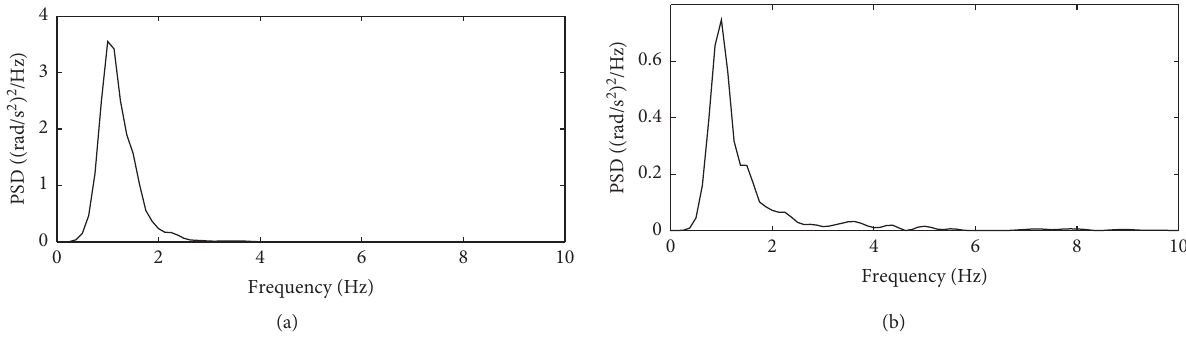
Figure 11: Roll response of upper human body under. (a) 1.4rad/s 2 r.m.s. roll vibration and (b) 1.4m/s 2 r.m.s. lateral excitation.